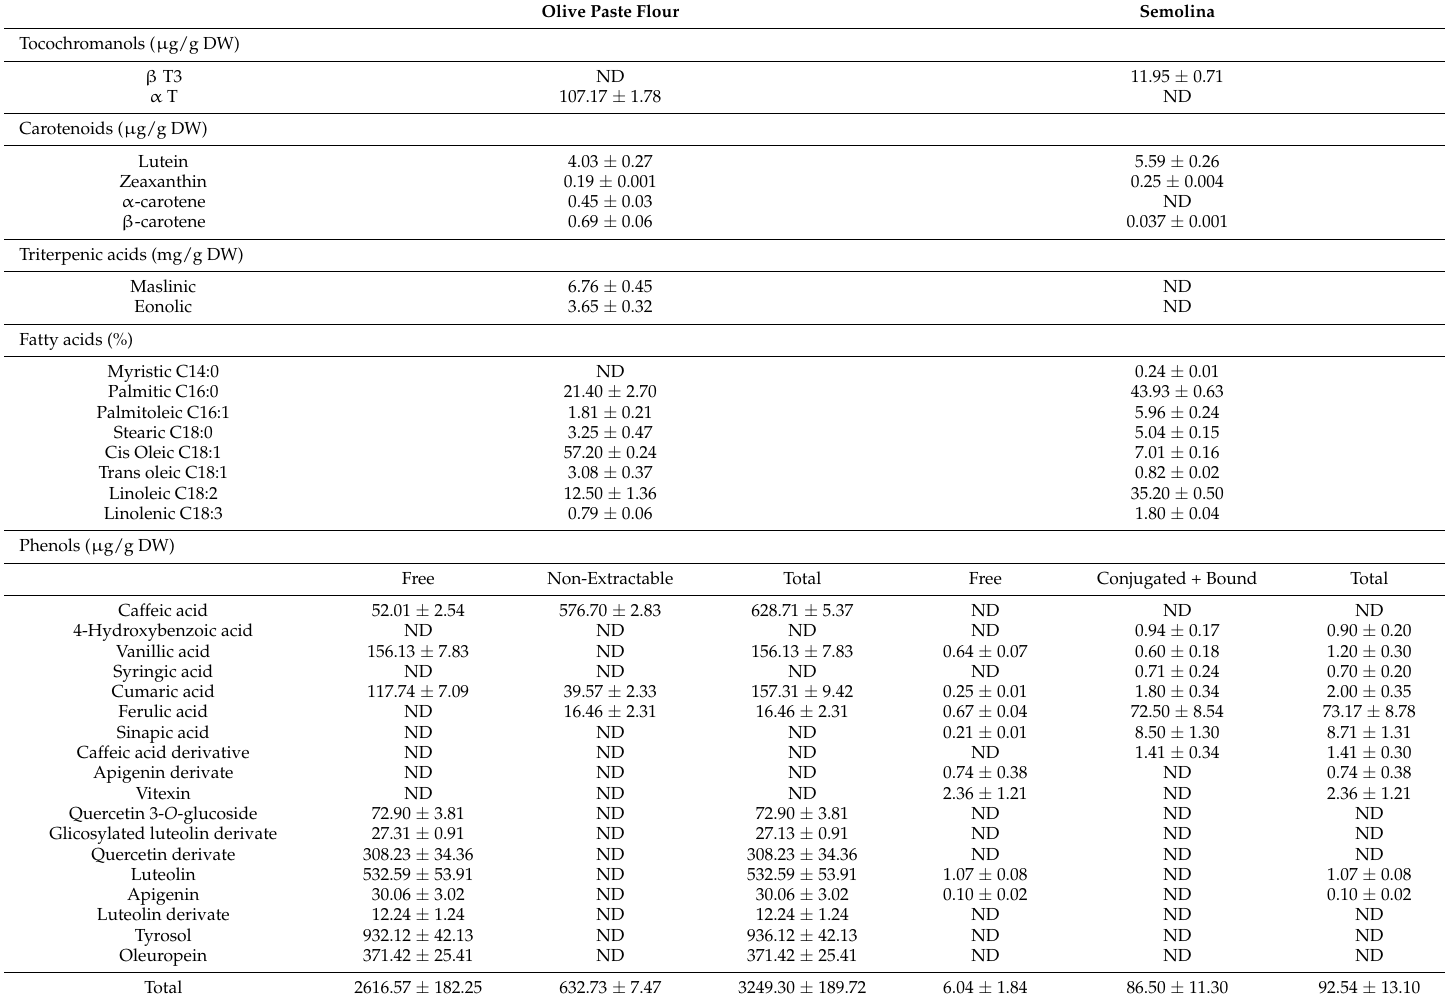
Table 1. Tocochromanols, carotenoids, fatty acids and phenolic composition of olive paste flour (OPF) and semolina Dry Weight (DW), ND: not detectable. Olive Paste